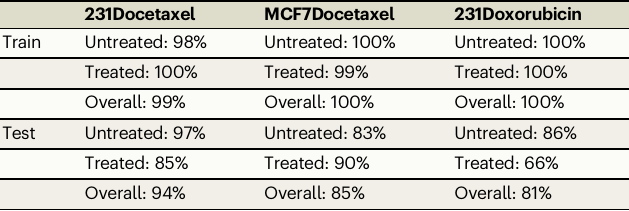
Table 2 | Ensemble classi fi cation accuracy scores for each data